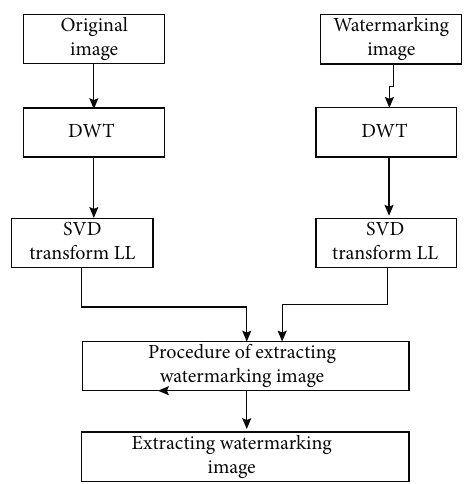
Figure 2: The watermark embedding